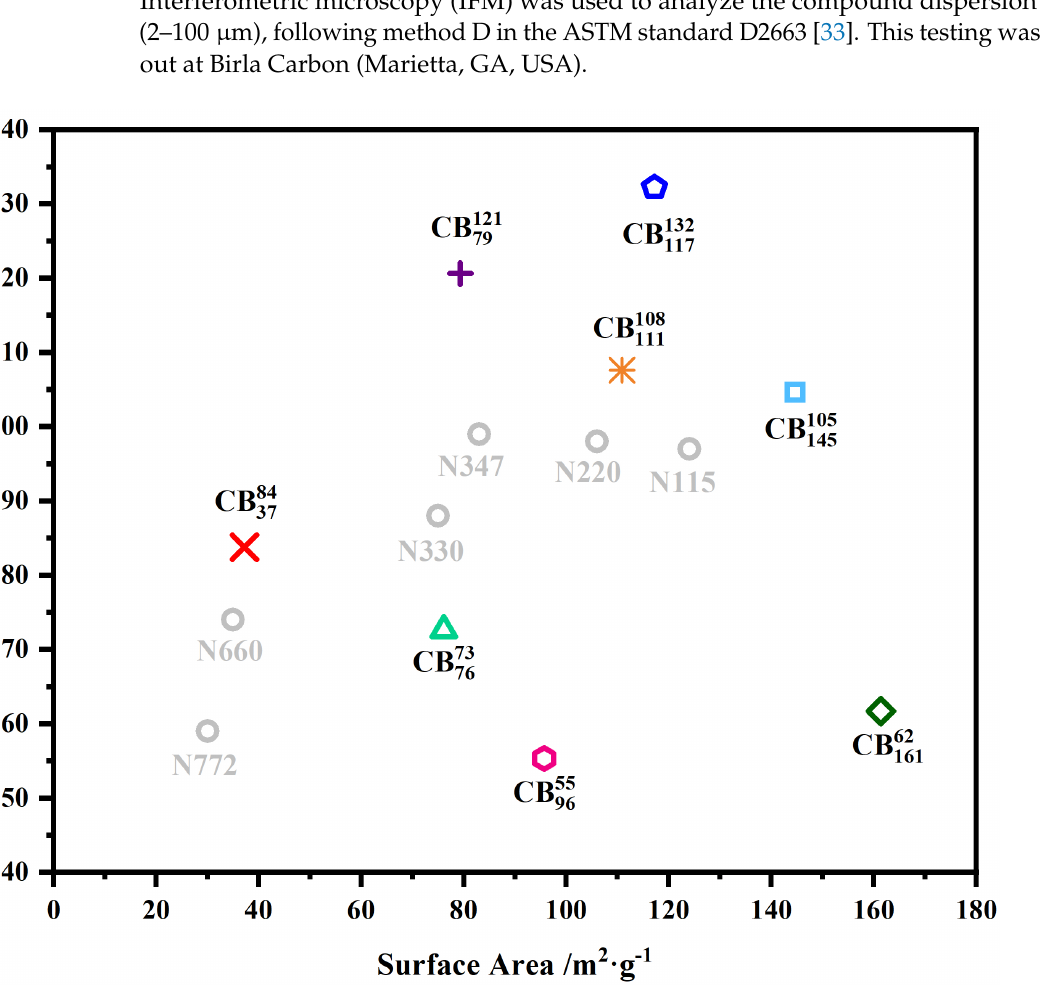
Figure 1. Colloidal plot of CBs, those in black were used during this study. Some conventional CBs have been written in grey for reference. Plot adapted from Kyei-Manu et al.